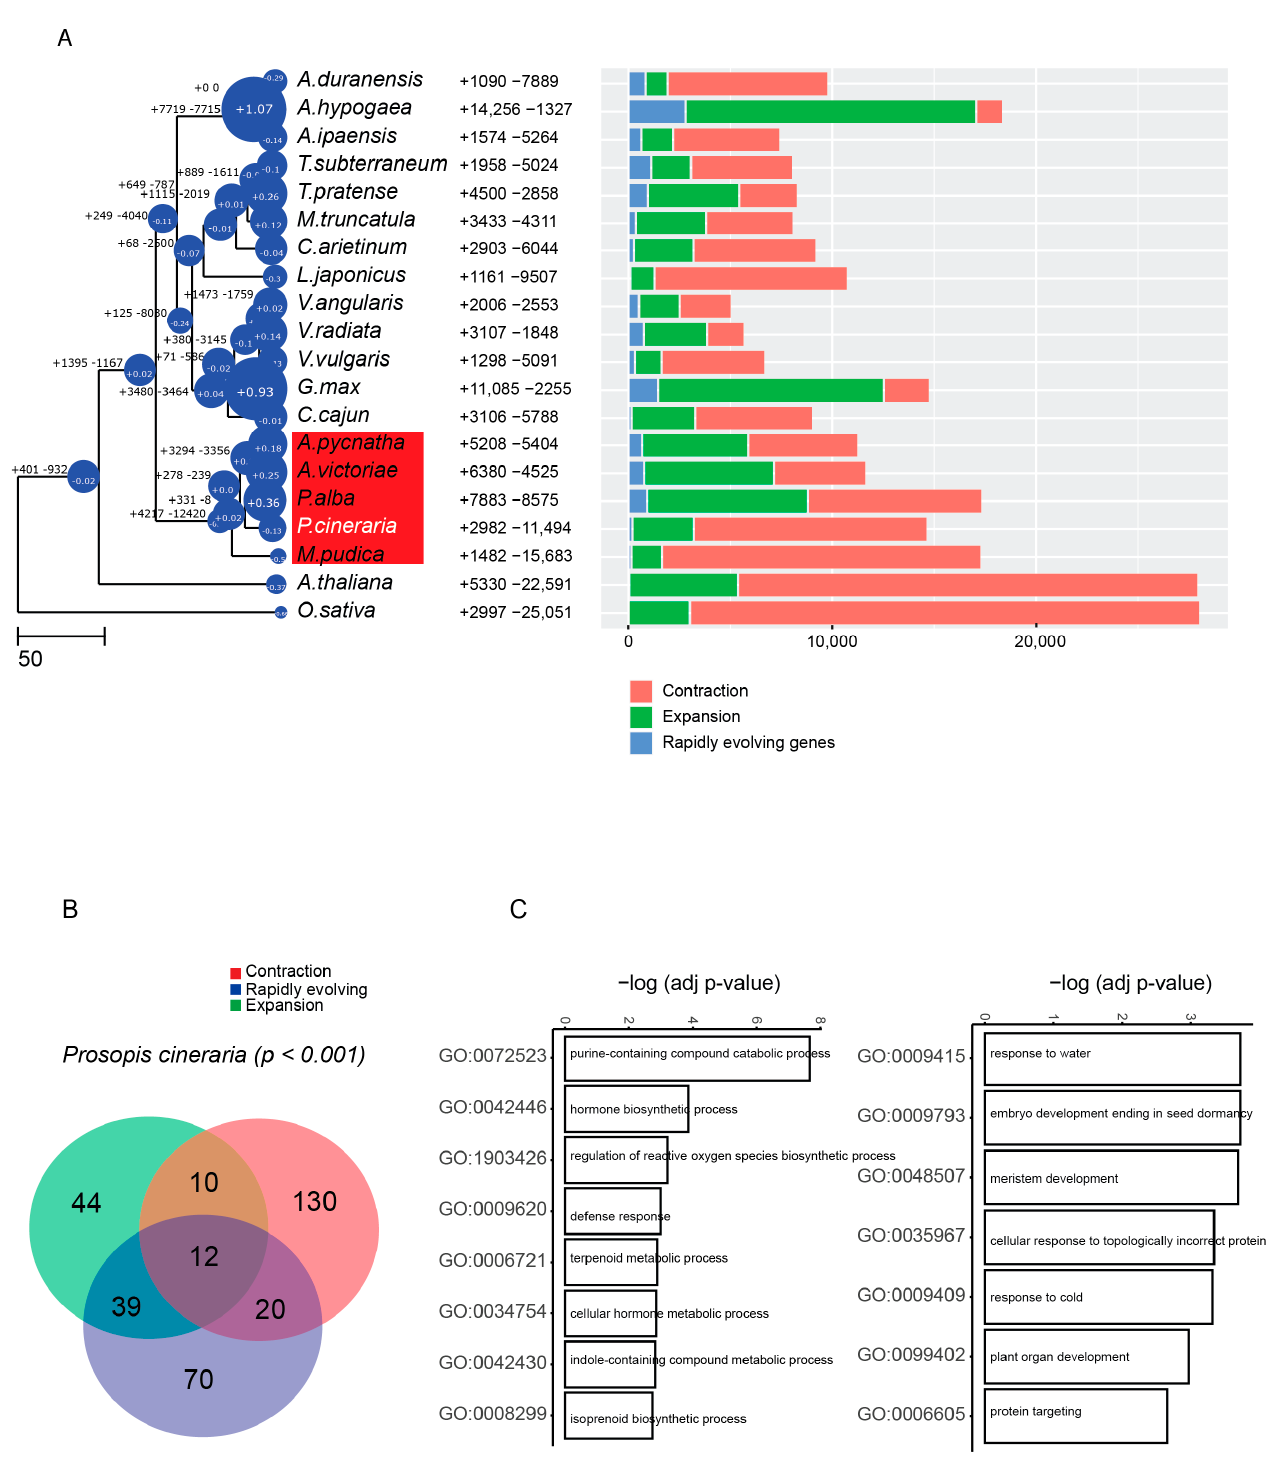
Figure 2. Genome evolution of P. cineraria . ( A ) Ultrametric tree of 18 legumes, including the mimosoid clade (highlighted by red box) and the two outgroups A. thaliana and O. sativa . CAFÉ analysis depicts total number of expanded and contracted gene families as well as rapidly evolving genes. The bubble on the node and leaf of the tree highlights the average expansion or contraction for each of the species, where a positive number depicts more expansion. ( B ) Venn diagram of top significant gene families ( p < 10 − 2 ) that are expanded or contracted in P. cineraria and under positive selection. ( C ) GO term enrichments of expanded gene families that are under selection ( left ) and contracted gene families under selection ( right ).